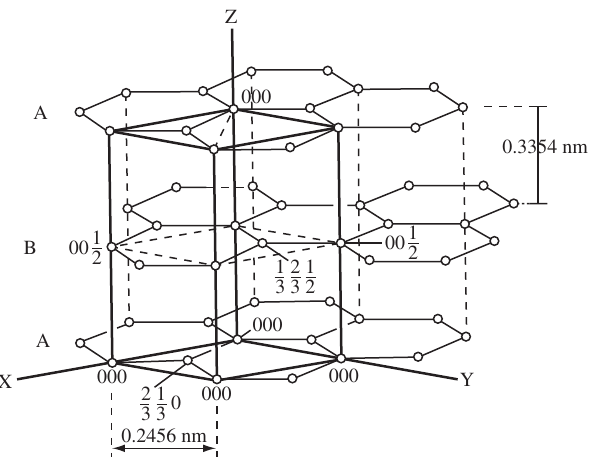
Figure 1. Representation of an ideal lattice of a graphite.